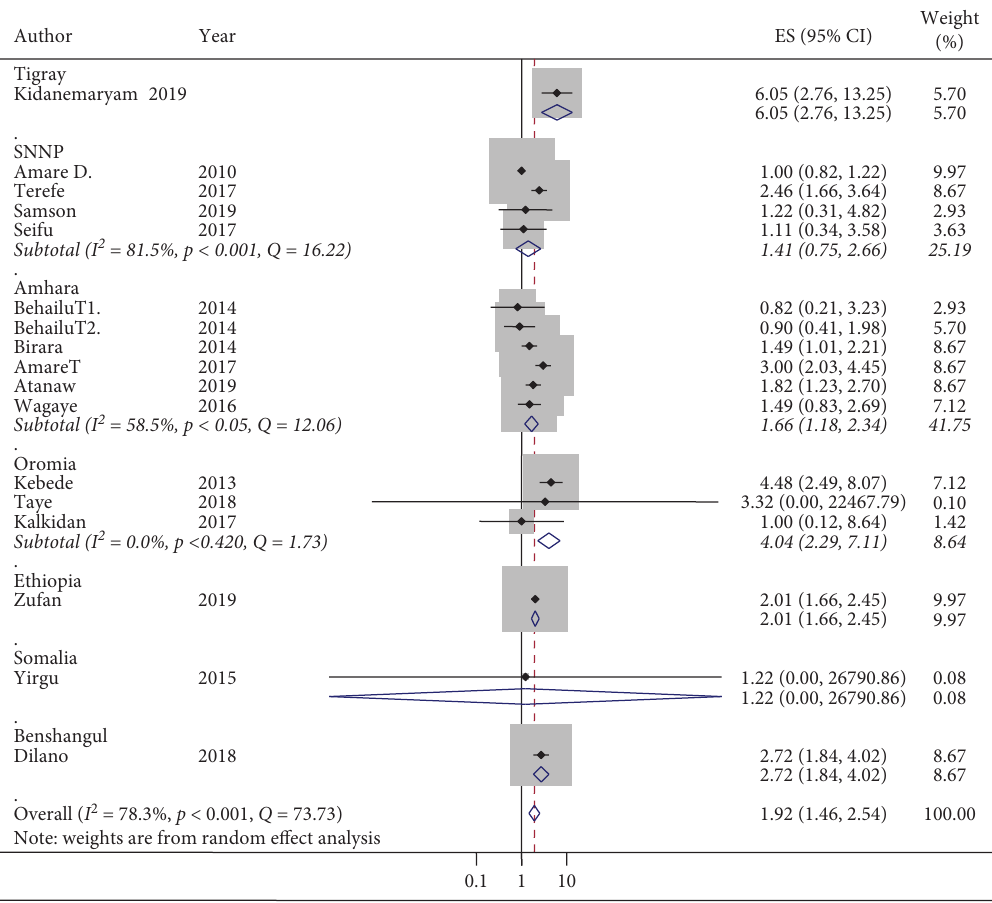
Figure 8: Subgroup analysis (by region) on the association of poor household wealth index and stunting and its 95% CI in Ethiopia,